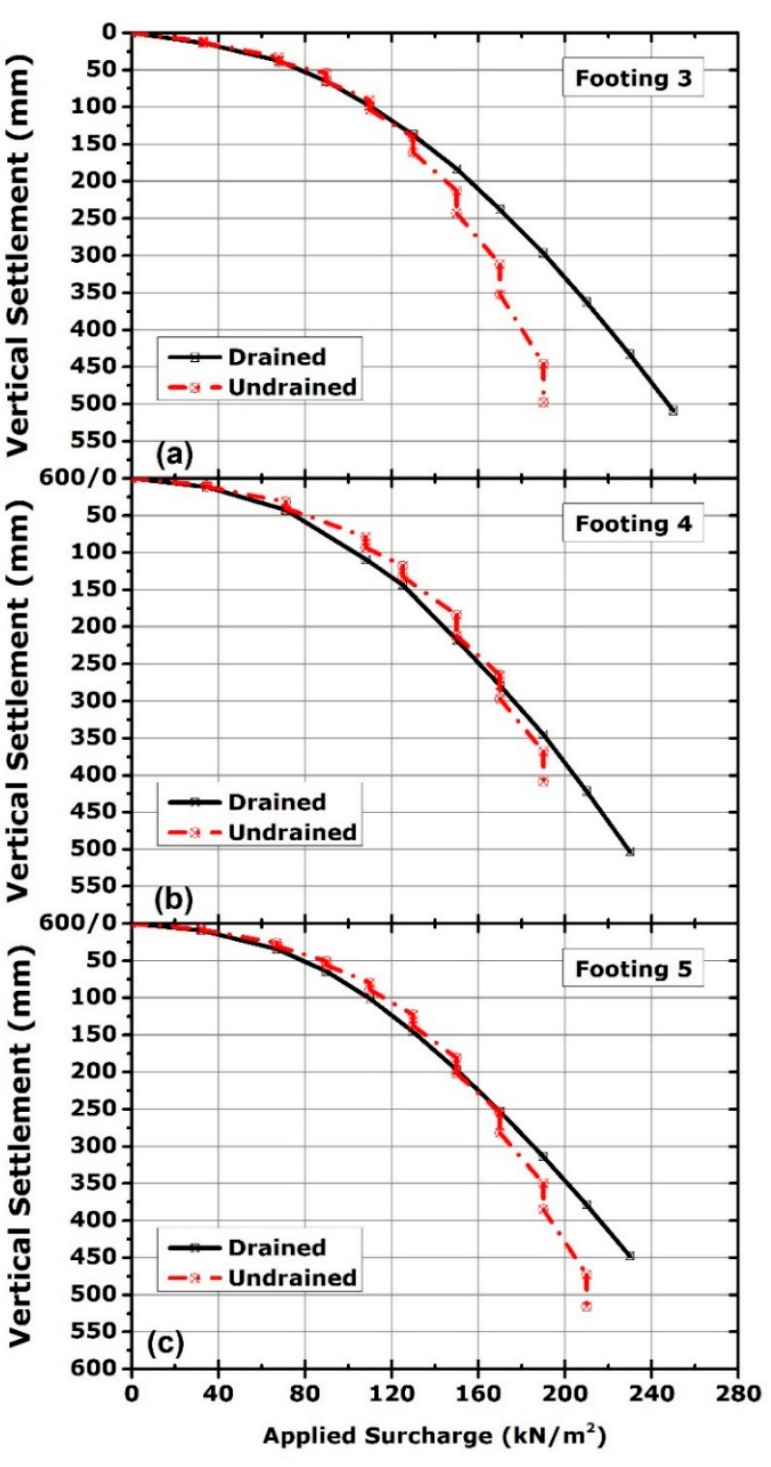
Figure 8. Load-displacement response for ( a ) Footing 3; ( b ) Footing 4; ( c ) Footing 5.